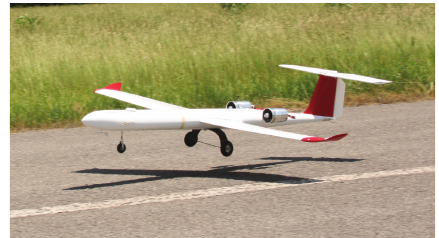
Figure 2: Picture of WVU “Red Phastball” aircraft.